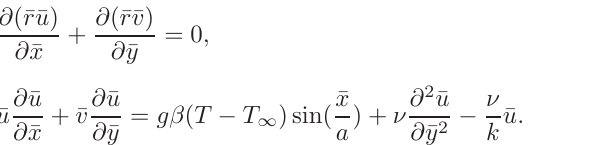
The governing boundary layer equations with the application of Darcy’s law [Vafai (2000) [14]] and under the Boussinesq approximation in the usual notation are given by